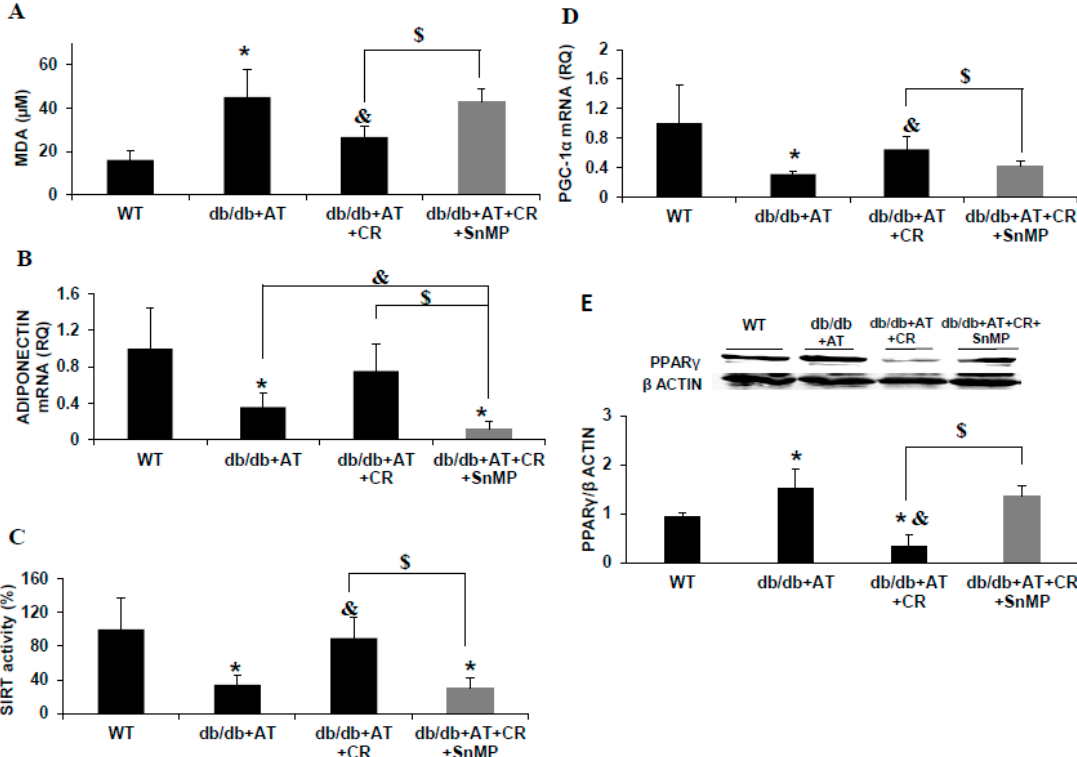
Figure 2. Sn(tin)-mesoporphyrin (SnMP) prevents the beneficial cellular e ff ect of CR. CR diabetic mice were concomitantly treated with SnMP. Malondialdehyde (MDA) levels in the serum were measured using thiobarbituric acid-reactive substances (TBARS) kit, n = 4 in each group. n = 4 in each group, * p < 0.007 vs. WT, & p = 0.009 vs. db / db + AT, $ p < 0.005 vs. db / db + AT + CR. Values represent mean ± SD ( A ). Adiponectin ( B ), SIRT1 ( C ), and peroxisome proliferator-activated receptor- γ coactivator (PGC-1 α ) ( D ) mRNA levels were measured in the cardiac tissue. n = 4 in each group, * p < 0.04 vs. WT, & p < 0.05 vs. db / db + AT, $ p < 0.04 vs. db / db + AT + CR. Values represent mean ± SD. Western blot for peroxisome proliferator-activated receptor y (PPAR γ ) protein and densitometry analysis of PPAR γ normalized to β actin. n = 4 in each group, * p < 0.03 vs. WT, & p = 0.004 vs. db / db + AT, $ p = 0.002 vs. db / db + AT + CR. Values represent mean ± SD ( E ). HO-1 protein levels were reduced in the heart ( F ).